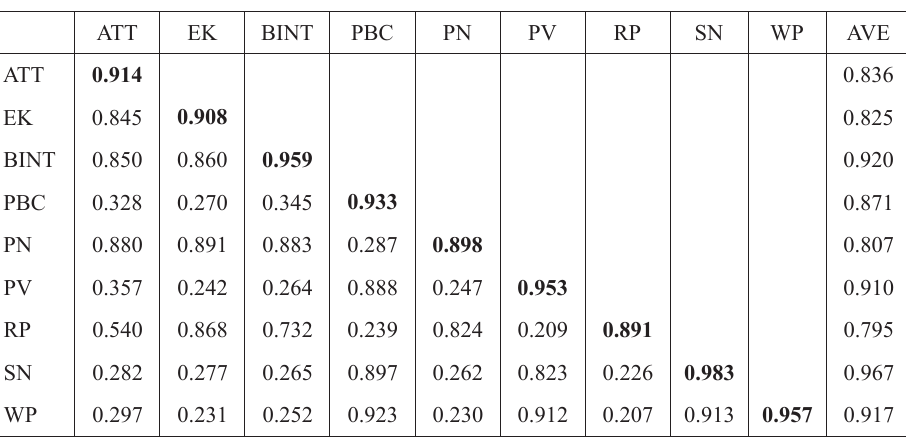
Table 5. The correlation matrix and discriminant